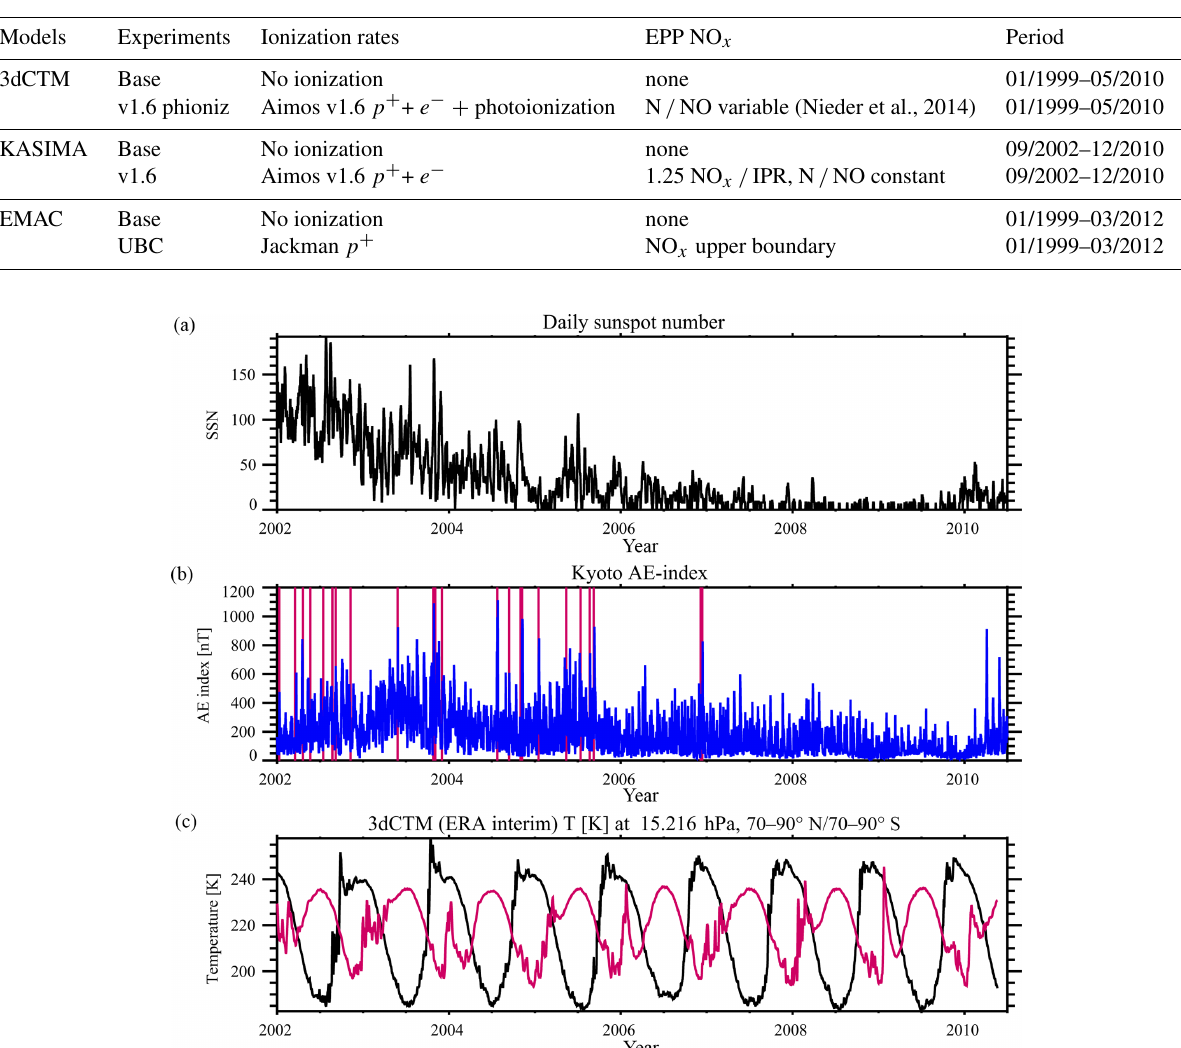
Figure 1. (a) Daily sunspot number from www.ngdc.noaa.gov/stp/spidr.html, May 2012. (b) Daily mean AE index from the Kyoto database (http://wdc.kugi.kyoto-u.ac.jp, February 2016). Red lines denote days of strong solar proton events as given by http://umbra.nascom.nasa. gov/SEP/, February 2017 (see text). For events lasting more than 1 day, only the first day is marked. (c) Temperature in the